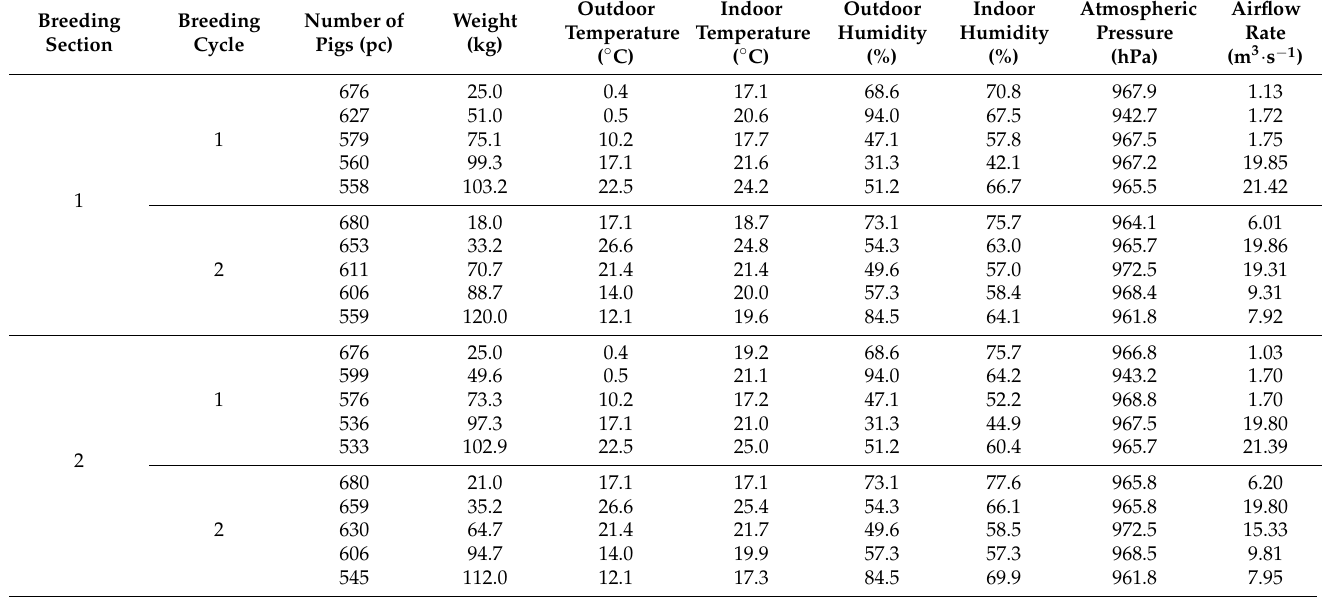
Table 4. Climatic and microclimatic conditions during the second approach